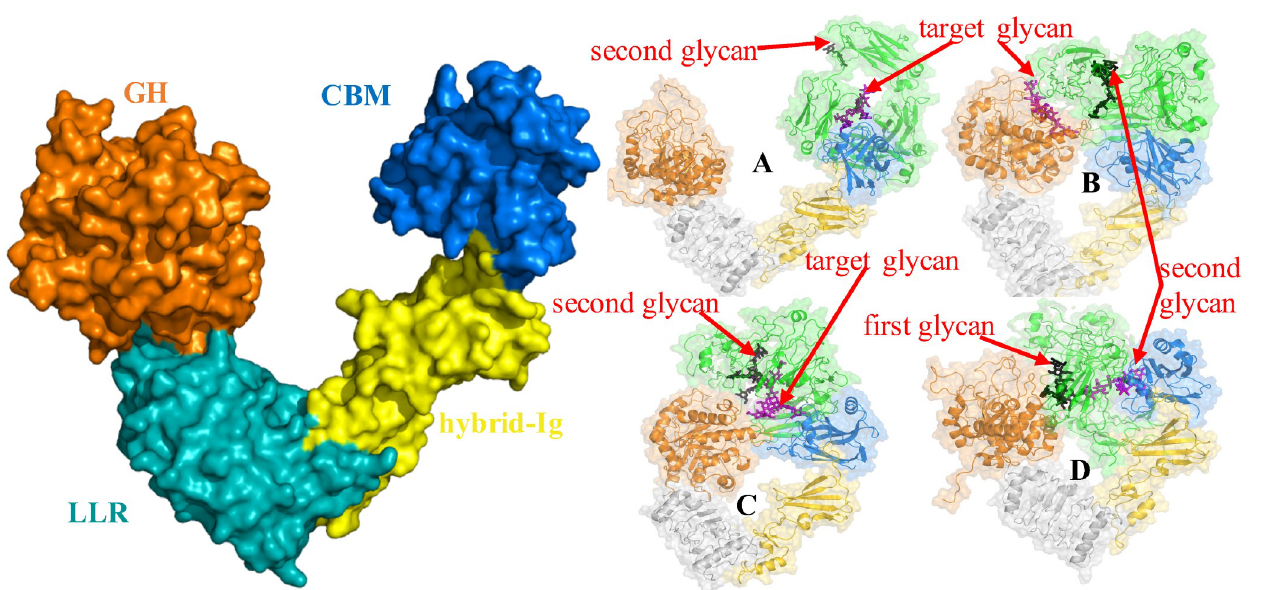
Fig 1. Left Panel: Structure of EndoS2 with annotated domains. Surface representation showing the general fold of EndoS2, including the glycoside hydrolase (GH; orange), leucine-rich repeat (LRR: cyan), hybrid IgG (hybrid-IgG: yellow) and carbohydrate binding module (CBM: blue) domains. Right panel (A to D): Initial conformations of Fc-EndoS2 complexes. Glycan locations are indicated with red arrows with models A to D shown on panels A to D, respectively. Only in the case of model D, which requires both glycans to be interacting with EndoS2, were both glycans simultaneous considered during model building while for the other three model only one of glycan, indicated as “target glycan” was used for model